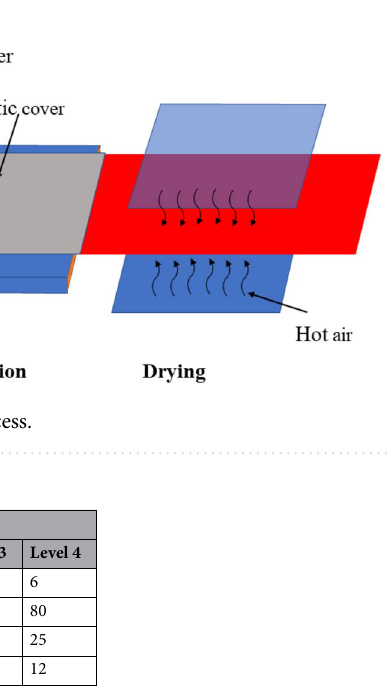
Table 1. L 16 orthogonal experimental design with their selected parameters and